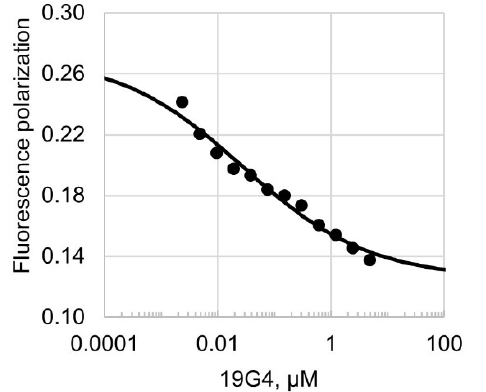
Figure 6. Competitive displacement curve of FAM-labeled 30Tf/30Bf (10 nM) from its preformed complex with Dnmt3a-CD by G4-containing unlabeled 19G4. The amount of displaced 30Tf/30Bf was assessed by fluorescence polarization assay; the measurements were carried out in buffer A in the presence of 100 µM AdoHcy.